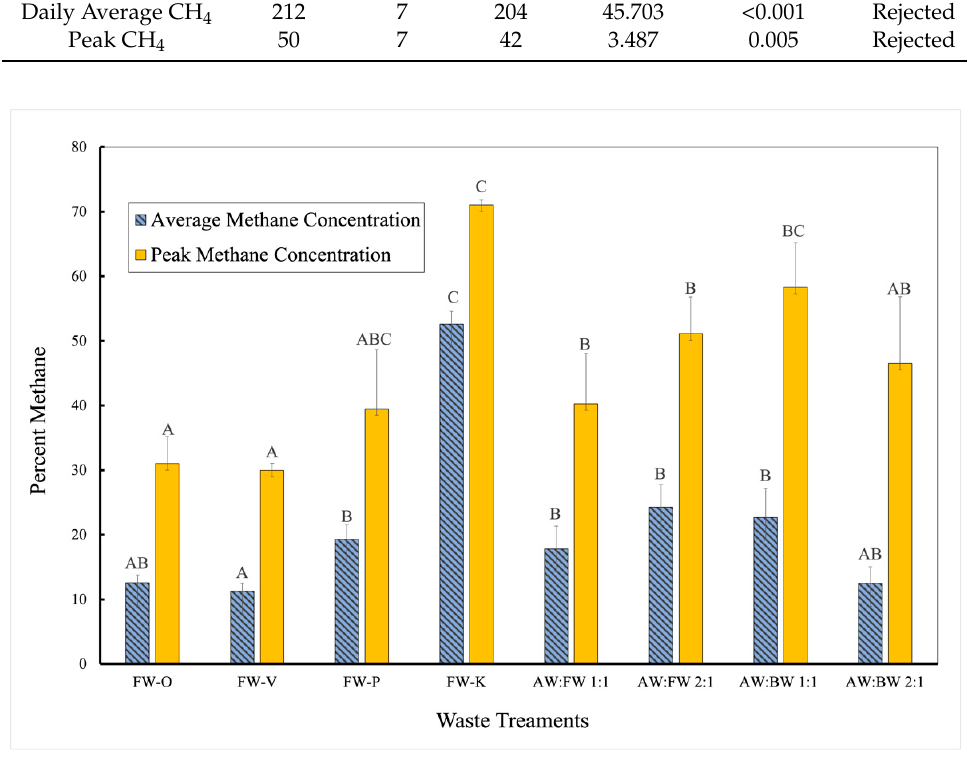
Figure 1. Average and peak methane concentrations produced by different anaerobically digested waste feedstock mixtures. Different letters indicate a statistical difference between treatment groups within each methane variable, and error bars represent standard error (See Section 2.1 for Statistic Analysis).